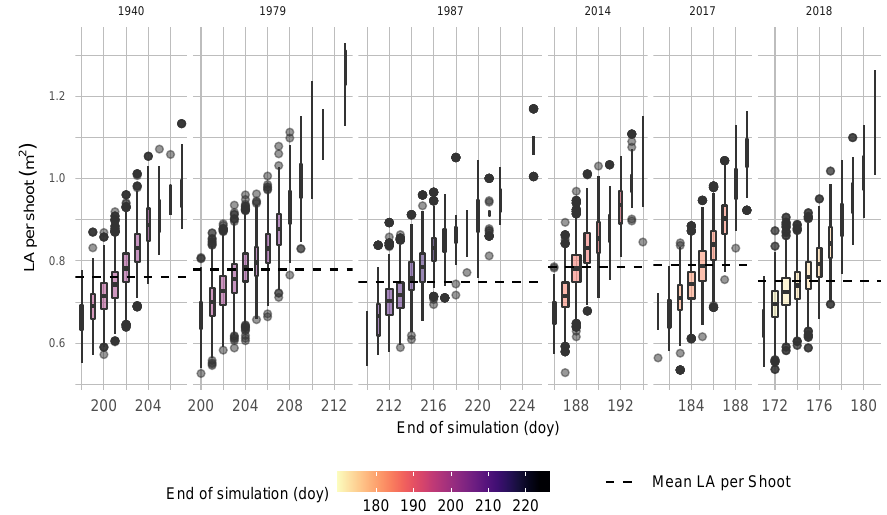
Figure 15. Total leaf area (LA) per shoot at the different end of simulation dates (DOY) for all years. Width of box plots indicate the number of simulations that ended at this date (total number of simulations per year: n =